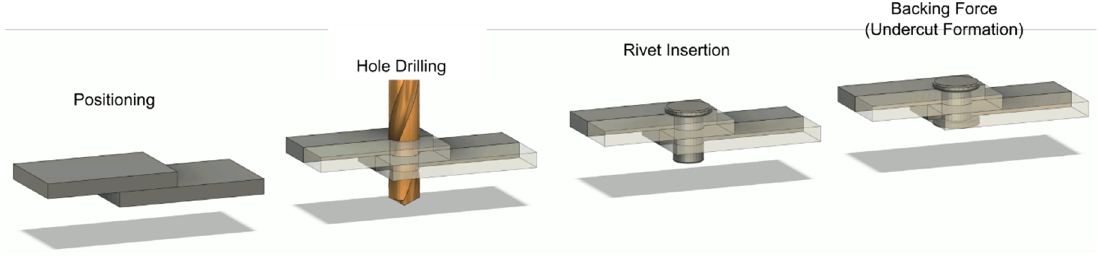
Figure 3. Main phases of riveting.